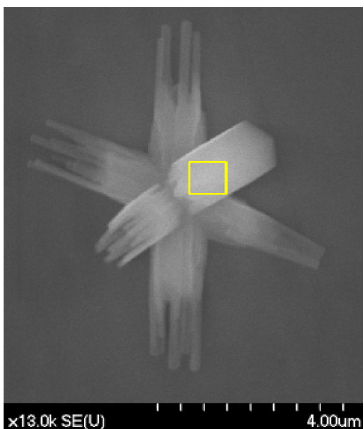
FIG. 13. SEM micrograph of one crystallite-like particle. The yellow box labels an area surveyed by EDX (see Fig. 14).